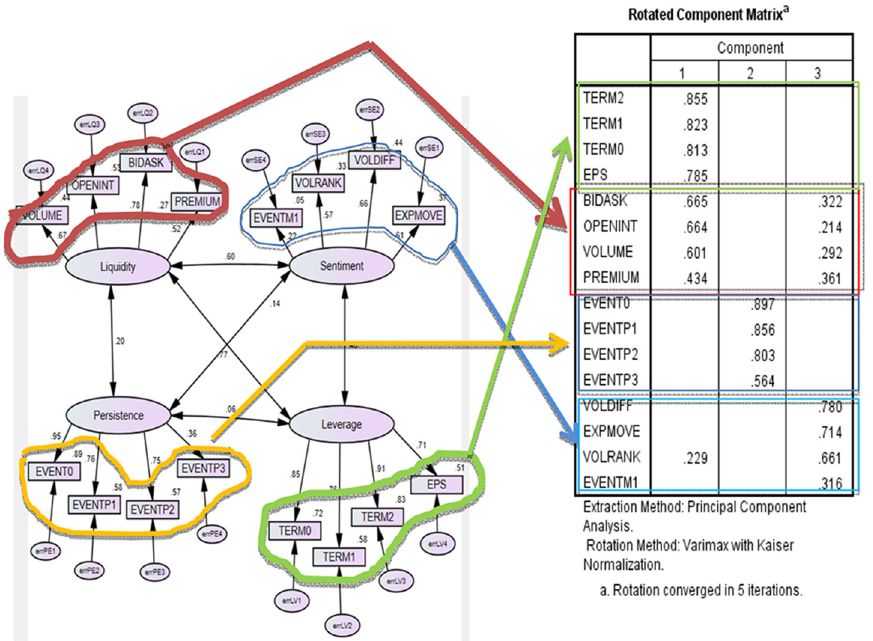
Figure 3. Rotated component matrix and SEM path